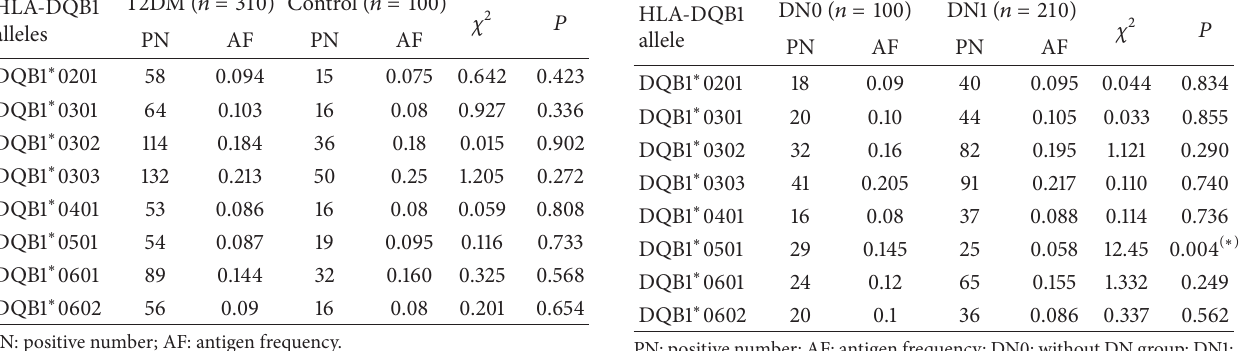
Table 3: Frequency of HLA-DQB1 alleles in T2DM group versus control group. HLA-DQB1